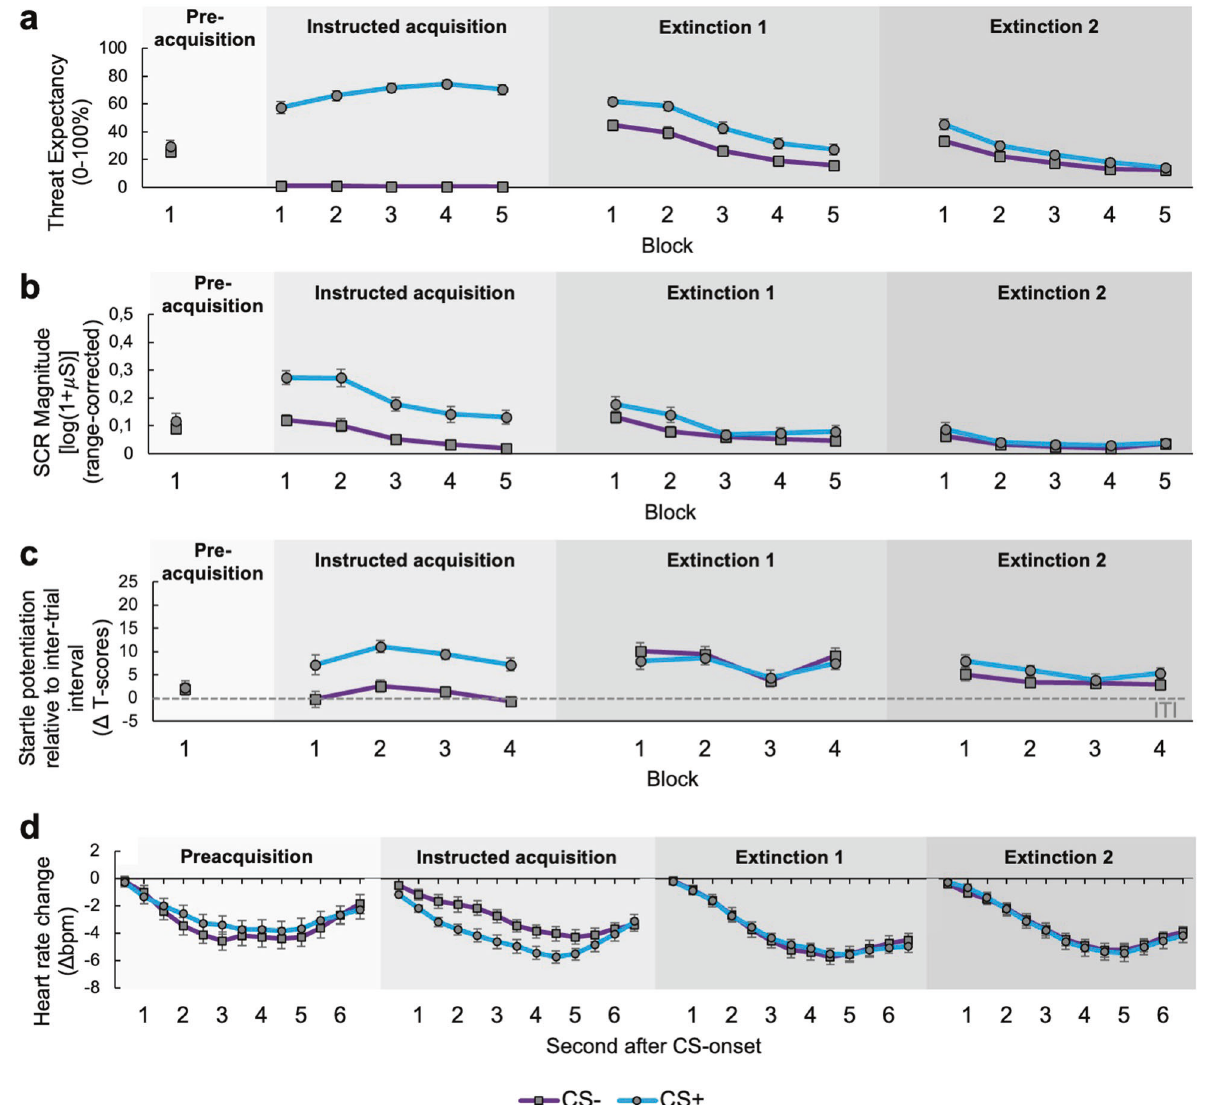
Fig. 3 Day 1: Establishment and extinction of the fear response. Overall mean US-expectancy ratings ( a ), range-corrected fi rst interval skin conductance responses ( b ), standardized (T-transformed) startle potentiation ( c ; response levels above 0 show a relative potentiation of the startle responses relative to the ITI control condition; note the relative increase in startle magnitudes probed during CS − from instructed acquisition to non-instructed extinction) and heart rate change ( d ) during the CS + (blue lines) vs. the CS − (purple lines) during preacquisition, instructed fear acquisition as well as the fi rst (extinction 1) and second half of extinction training (extinction 2). US-expectancy, skin conductance and startle potentiation are averaged across blocks of two trials, while heart rate change is averaged across all trials of a respective phase. Error bars represent the standard error of the